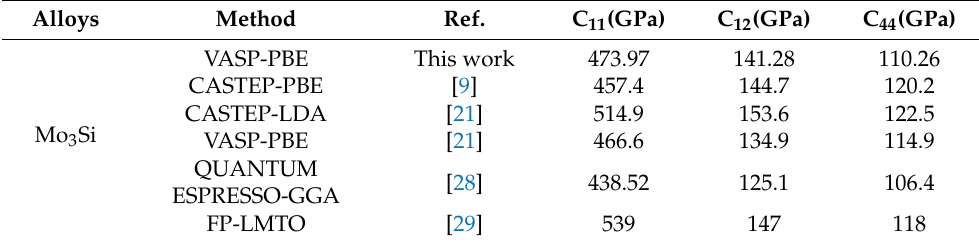
Table 1. Elastic constants of Mo 3 Si.